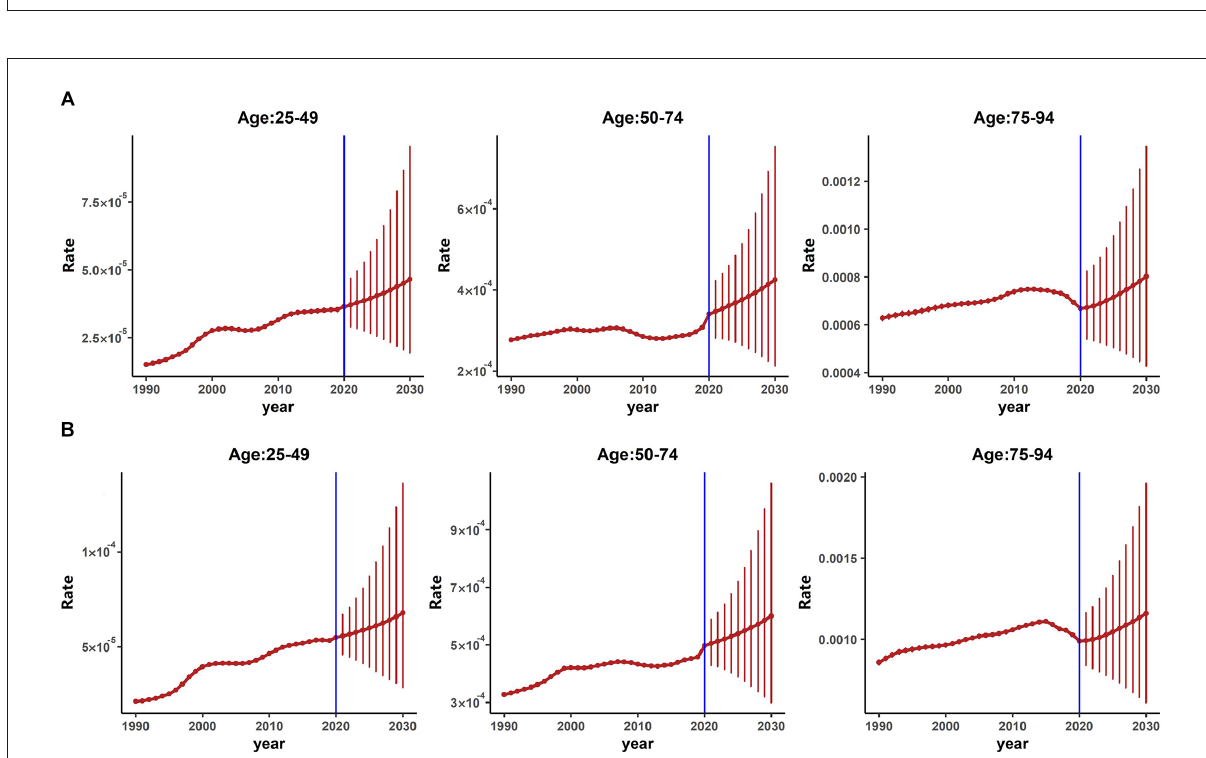
FIGURE2 Projected age-specific incidence of PD from 2020 to 2030 by gender. (A) Projected age-specific PD incidence for females. (B) Projected age-specific PD incidence for males.